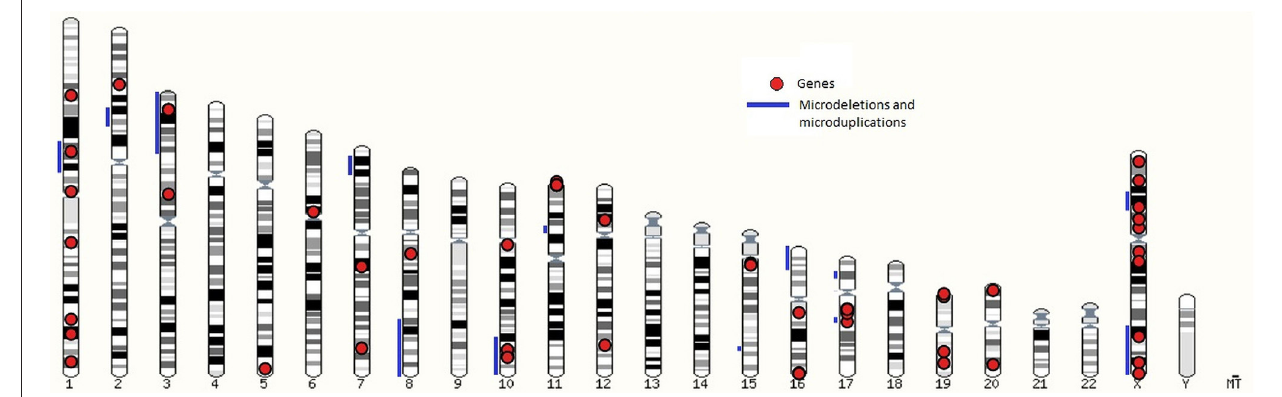
FIGURE 2 | Portrayal of cryptorchidism associated syndromes and genetic loci.